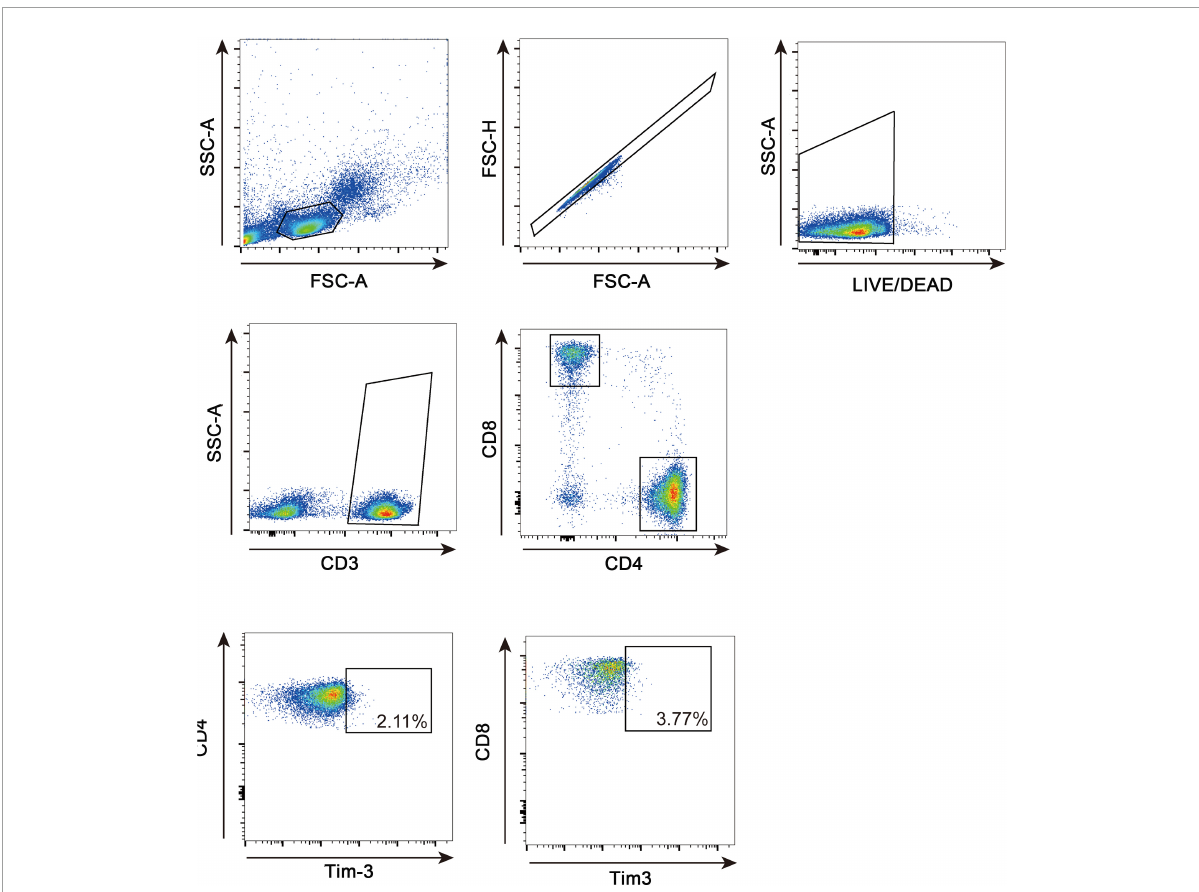
FIGURE1 FACS gating strategy for lymphocytes. Representative flow cytometric dot plots to determine CD4 + and CD8 + lymphocytes in human PBMCs. PBMC were gated as lymphocytes on forward and side scatter density plots. Then, singlets were gated on FSC-A and FSC-H plots, and live cells were gated for subsequent analysis. CD4 + and CD8 + T cells were identified from the positive population for CD3. CD4 + Tim-3 + and CD8 + Tim-3 + subpopulation were gated on CD4 + and CD8 + T cells,